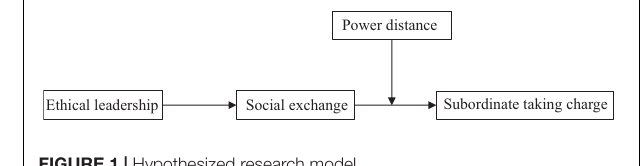
FIGURE 1 | Hypothesized research